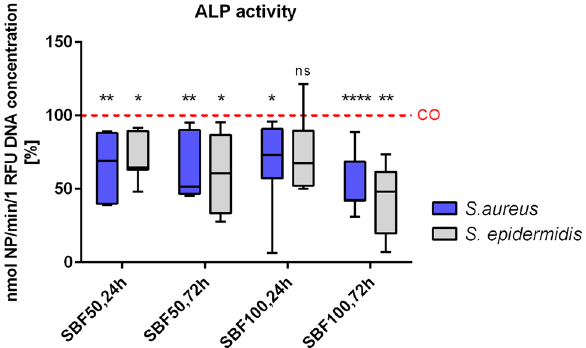
Figure 5. ALP activity after stimulating osteoblasts with SBF. ALP was measured and normalized against total DNA amount. Both concentrations of S. aureus and S. epidermidis SBF impact the ALP activity and resulted in a